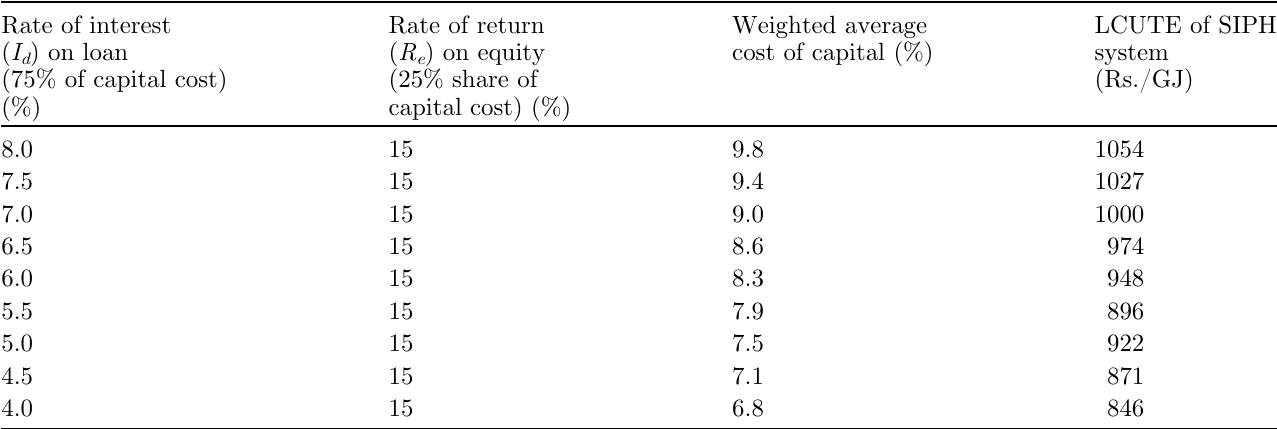
Table 3. Effect of rate of interest on loan on the levelized cost of useful thermal energy (LCUTE). Rate of interest